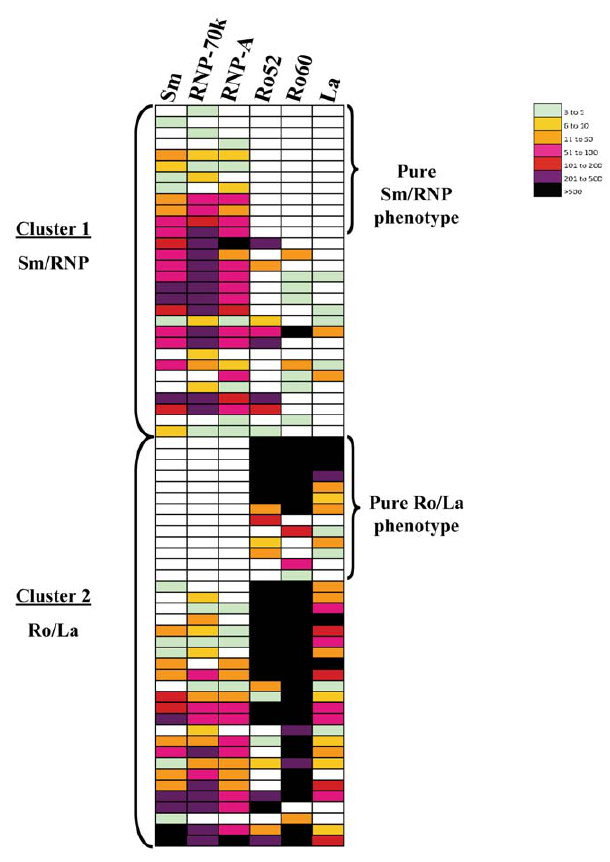
Figure 1. SLE autoantibody clusters in the pilot cohort. A colored heat map was used to visualize the autoantibody titers in the SLE patients. Autoantibody titers were transformed to Z scores as described in the Materials and Methods and color coded as indicated by the scale at right, in which signal intensities from green to black indicate high and low titers, respectively. To segregate the SLE patients into clusters, the relative ratio (RR) of the sum titer of Sm-D3, RNP-A and RNP-70k divided by the sum titer of Ro52, Ro60 and La autoantibodies was calculated for each patient. Patients with a RR $ 1 were assigned to the Sm/RNP cluster (top panel) while patients with a RR , 1 were assigned to the Ro/La cluster (bottom panel). Patients with a pure Sm/ RNP or pure Ro/La phenotype are